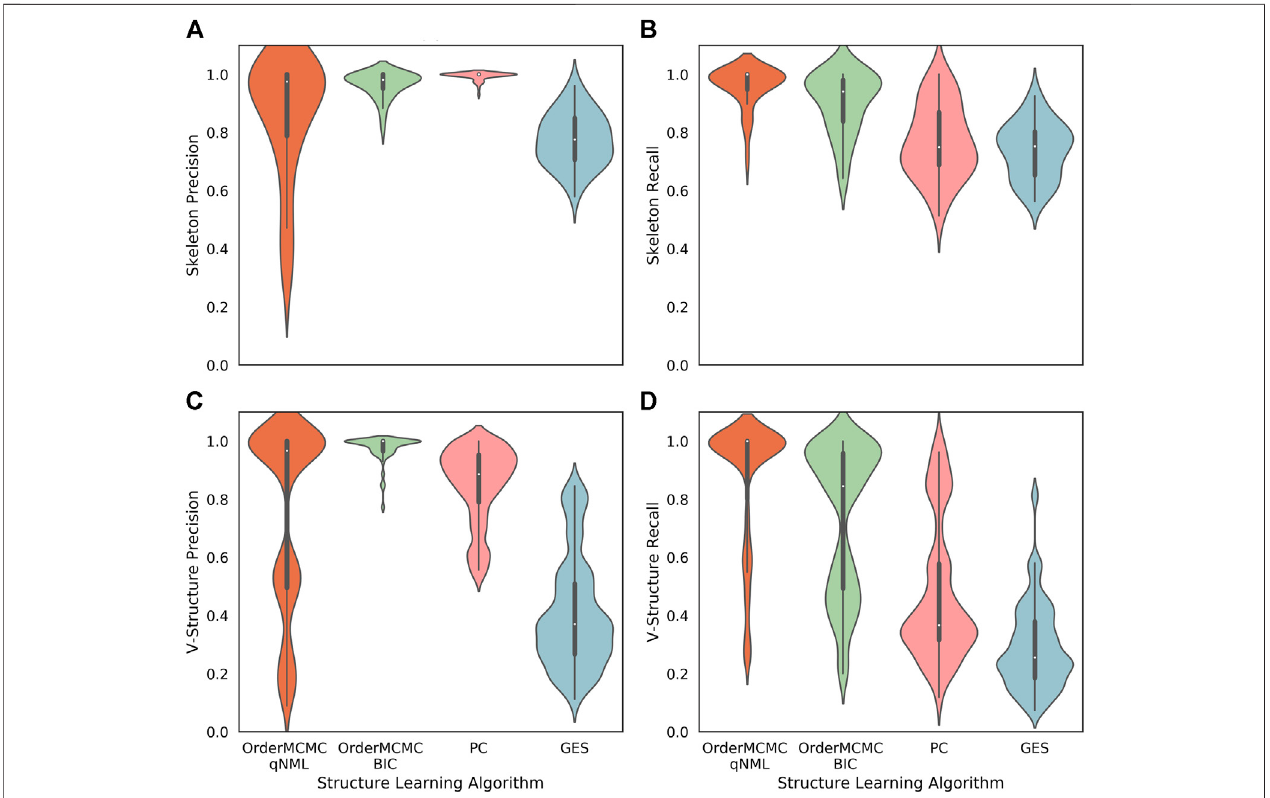
FIGURE 6 | Performance obtained running the structure learning algorithms on the datasets produced for the Surgo Household datasheet (Datasheet for Existing Datasets). The width of the violin plots are the kernel density estimates of the distribution, the white dots represent the median, and the vertical thick and thin lines represent the IQRs and ranges respectively. (A) : Skeleton Precision; (B) : Skeleton Recall; (C) : V-structure Precision; (D) : V-structure Recall. From this fi gure we can see good skeleton performance can be obtained using OrderMCMC, but V-Structures are more likely to be correct (precision) when using the BIC and less likely to be missed (recall) when using the qNML